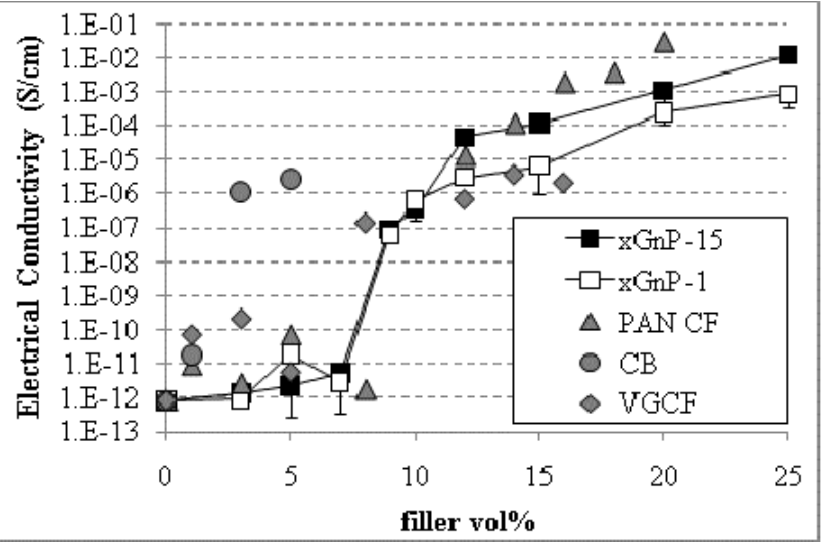
Figure 1. Electrical conductivity of carbon reinforced PP composites as a function of the filler